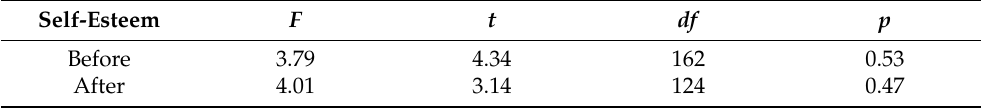
Table 6. Student t -test results for dependent samples in the group of women before and after the procedure and the level of assessment of their